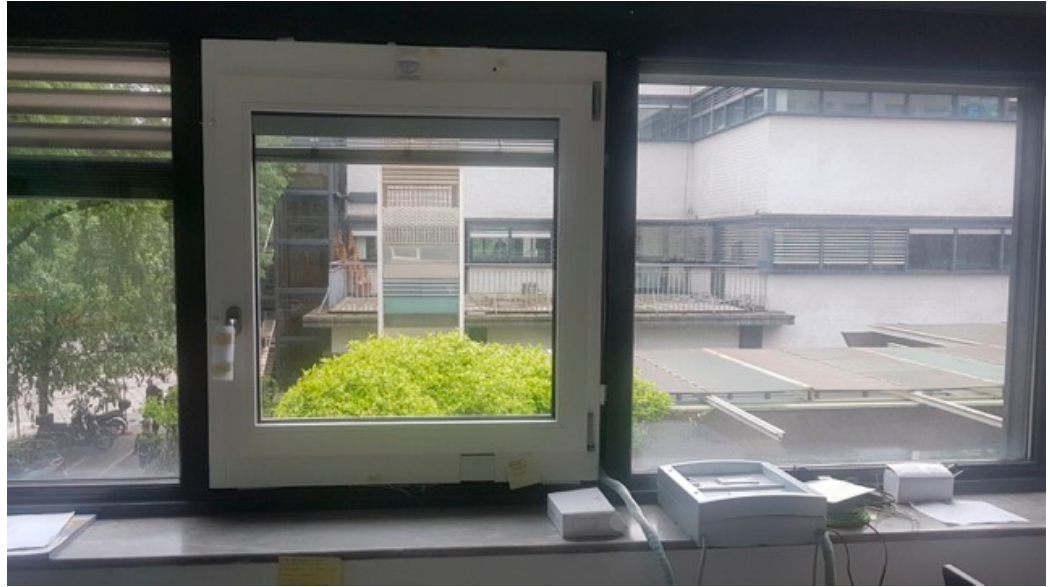
Figure 7. The window system (Prototype 2, case study 1) installed on site, equipped with a control unit (Italserramenti, SeedLab.ABC, Dip. ABC, Politecnico di Milano, Schneider Electric).